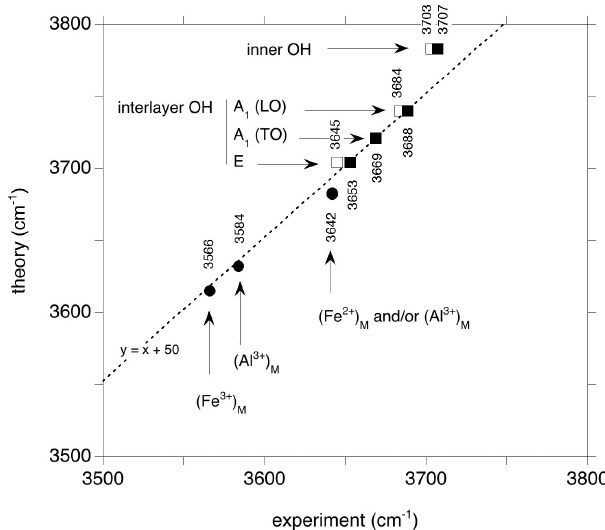
Figure 5. Relation between the theoretical frequencies (Fig. 1) and experimentally observed vibrational bands. Open squares: FTIR spectrum of Monte Fico lizardite (Balan et al., 2002); full squares: Raman frequencies of Monte Fico lizardite (Compagnoni et al., 2021). Black circles: signals ascribed to cationic impurities in the vibrational spectra of the Monte Fico and Lz1 lizardite. The average value of theoretical frequencies related to (Fe 2 + ) M (3683cm − 1 ) almost coincides with the higher-frequency contributions related to Al 3 + cations (3682cm − 1 ). The theoretical model overestimates the experimental stretching frequencies of interlayer-OH groups by ∼ 50cm − 1